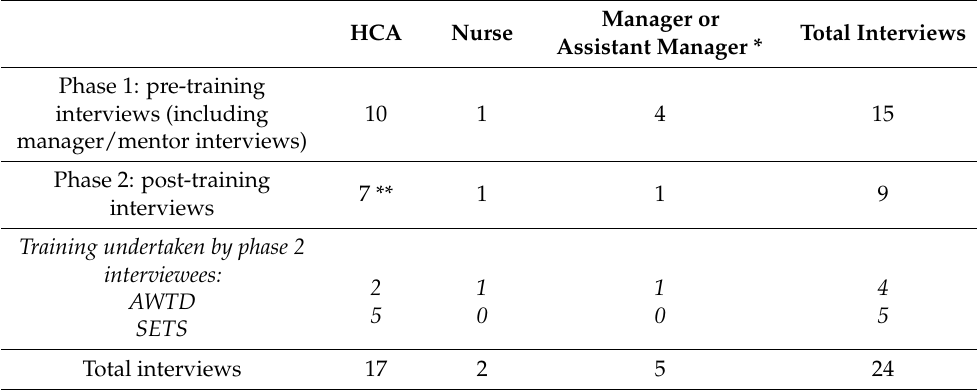
Table 1. Interview participants’ current job role, phase of study participation and training